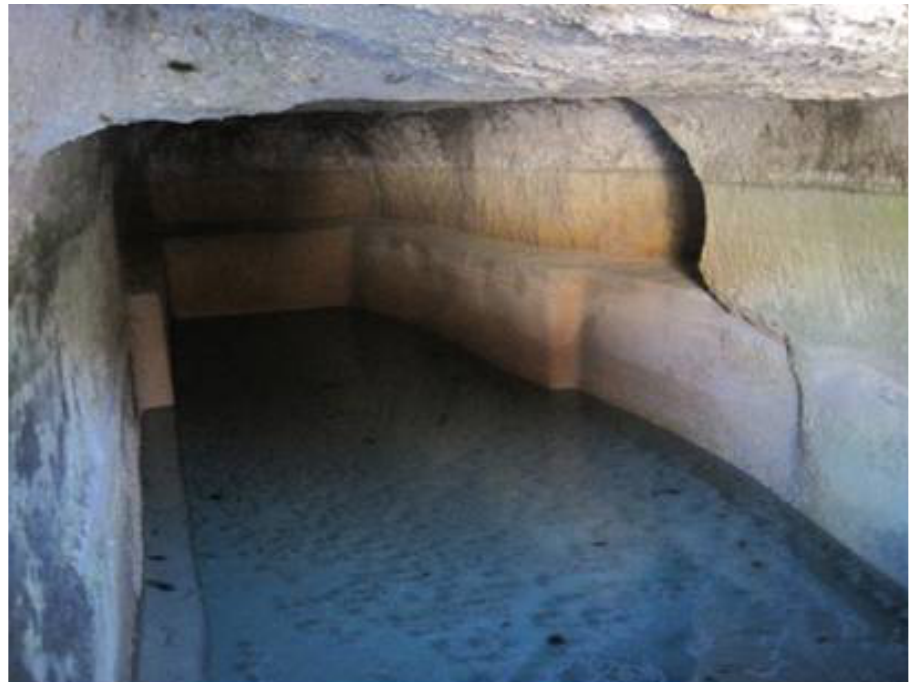
Figure 7. Rock-cut cistern at the end of aqueduct 1